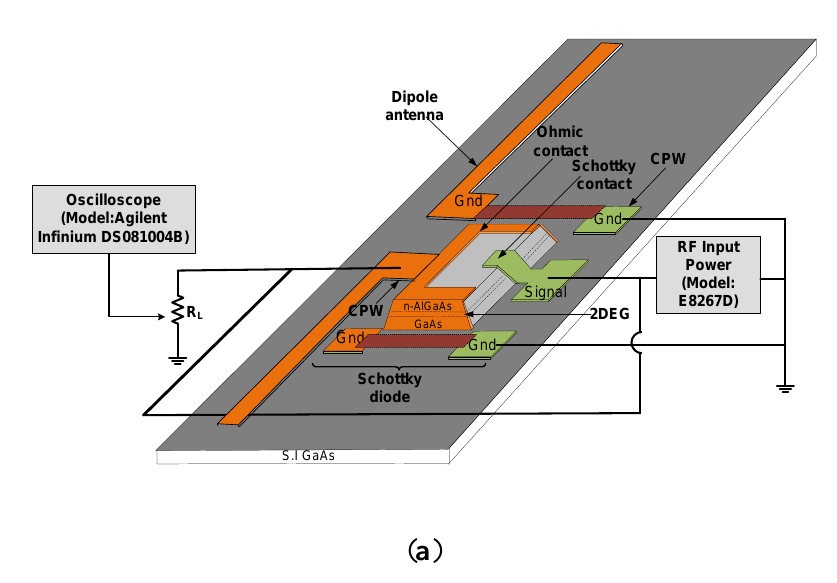
Figure 1. ( a ) Schematic and ( b ) top view photo of the rectenna device.